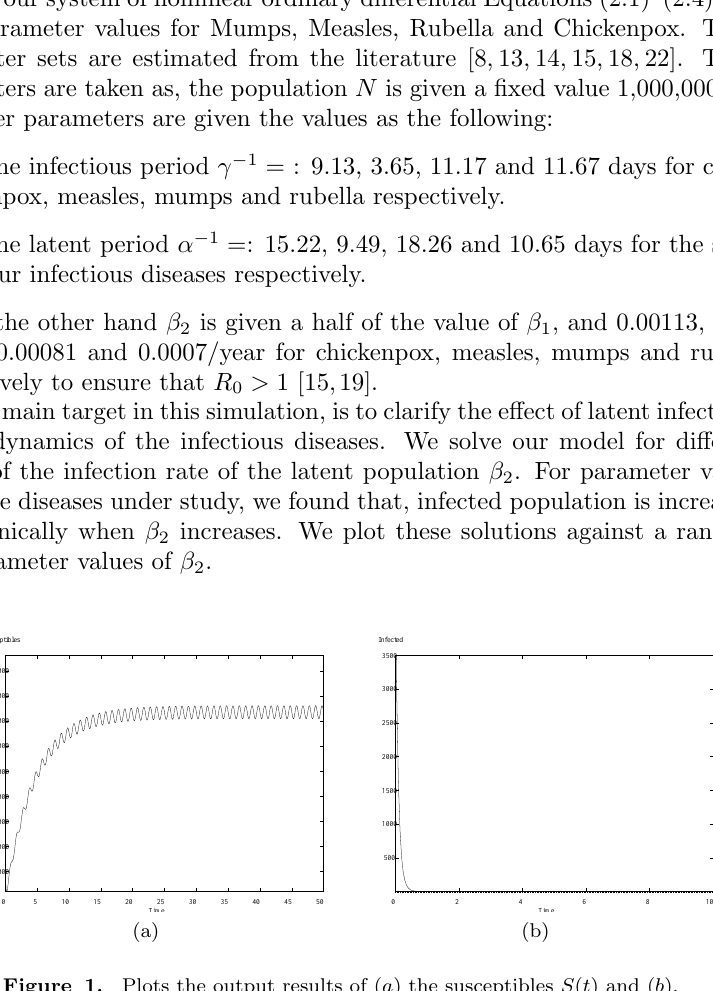
Figure 1. Plots the output results of ( a ) the susceptibles S ( t ) and ( b